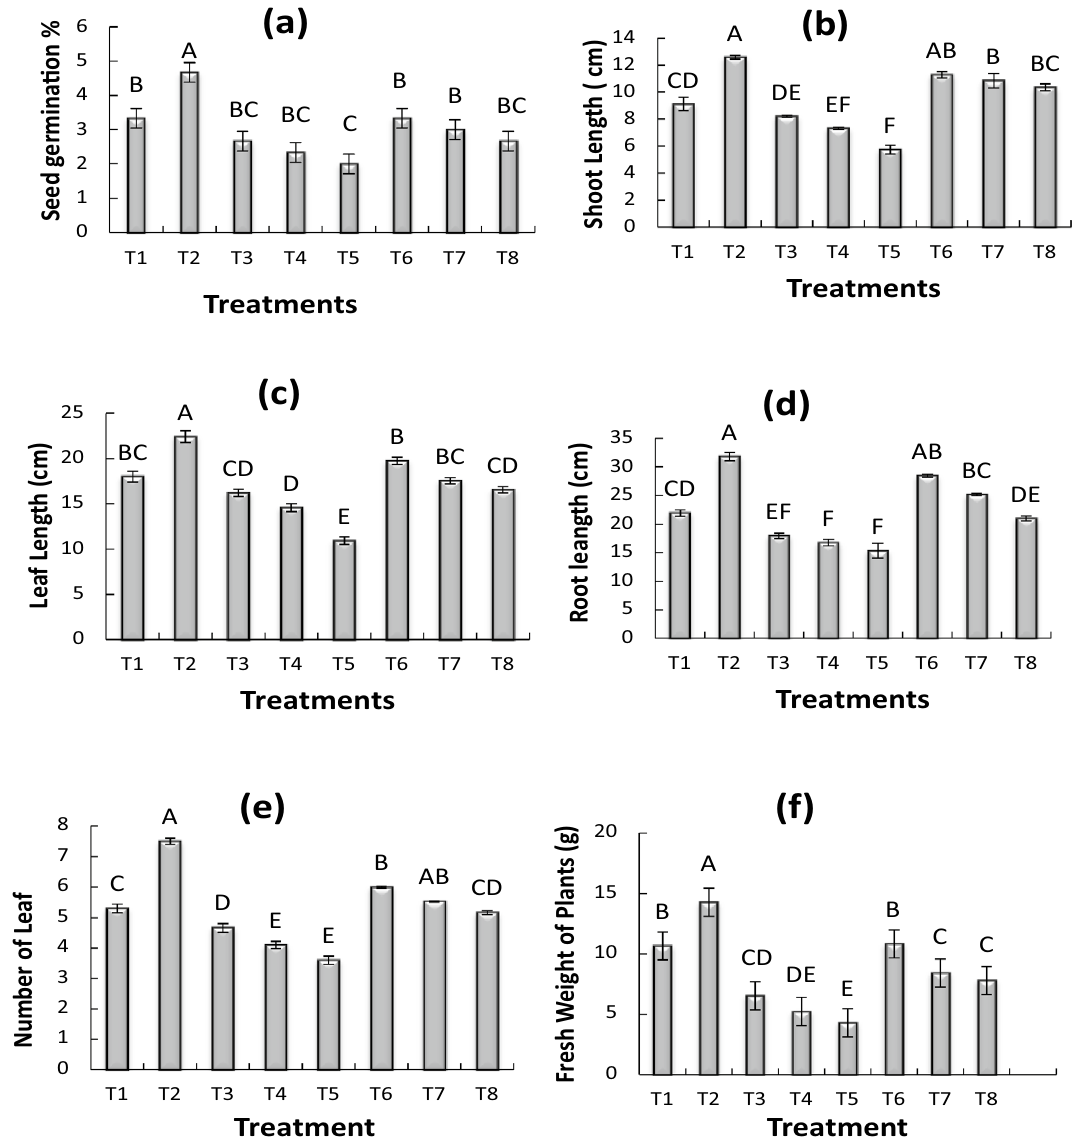
Figure 1. Effect of Cadmium (Cd) on Maize Seed Germination % ( a ), shoot length ( b ), leaf length ( c ), root length ( d ), no. of leaves ( e ), fresh weight ( f ). All treatments sharing common letter with similar bar pattern are similar otherwise differ significantly at p < 0.05. T1 = control, T2 = inoculated seed, T3 = 0.25 mg